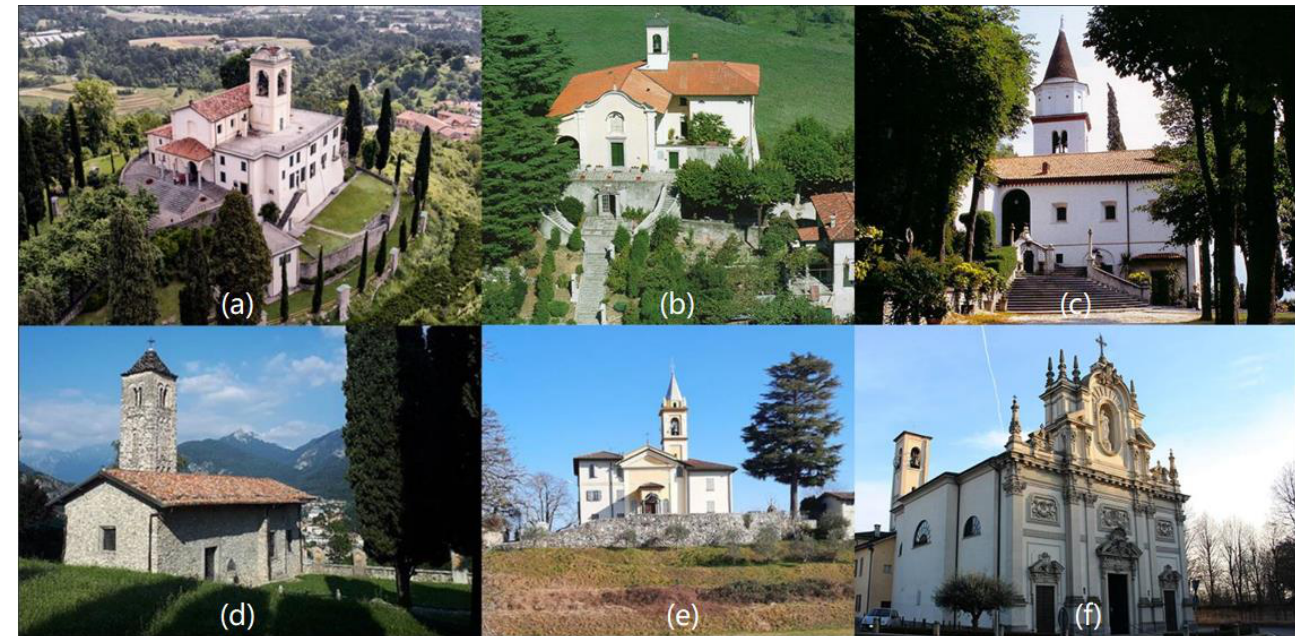
Figure 1. Six of the fifty Marian Sanctuary on the St. Augustine Route. In the first row ( a ) Santuario della Beata Vergine del Carmelo-Montevecchia (LC), ( b ) Santuario della Madonna della Pace alla Rocchetta-Airuno (LC), ( c ) Santuario della Madonna di San Martino-Valmadrera (LC); in the second row ( d ) Santuario della Madonna di San Calogero-Caslino d’Erba (CO), ( e ) Santuario di Nostra Signora di Lourdes-Monguzzo (CO), and ( f ) Santuario Beata Vergine Maria dei Miracoli-Cantù (CO).